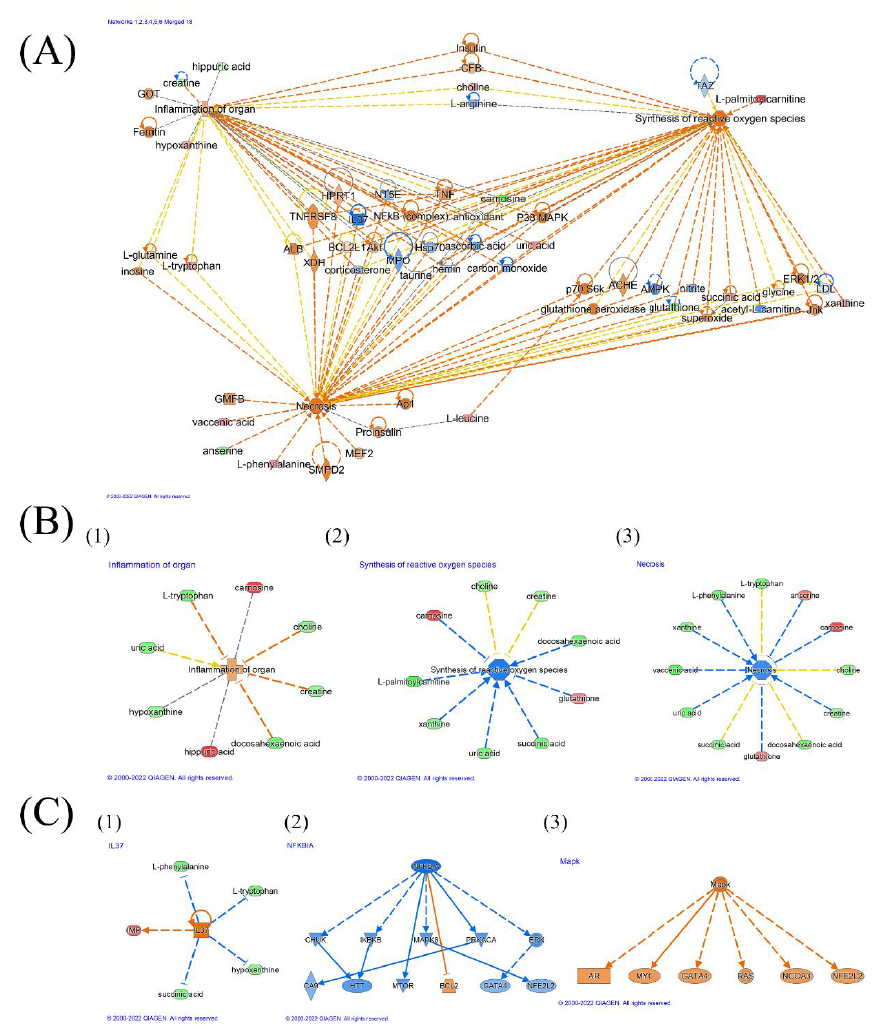
Figure 4. ( A ) Network analysis of called-back metabolites in this work. ( B ) Network analysis of symptoms of (1) organ inflammation, (2) synthesis of reactive oxygen species, and (3) necrosis. ( C ) Network analysis of pathological factors of (1) IL-37, (2) NFkBIA, and (3) MAPK.